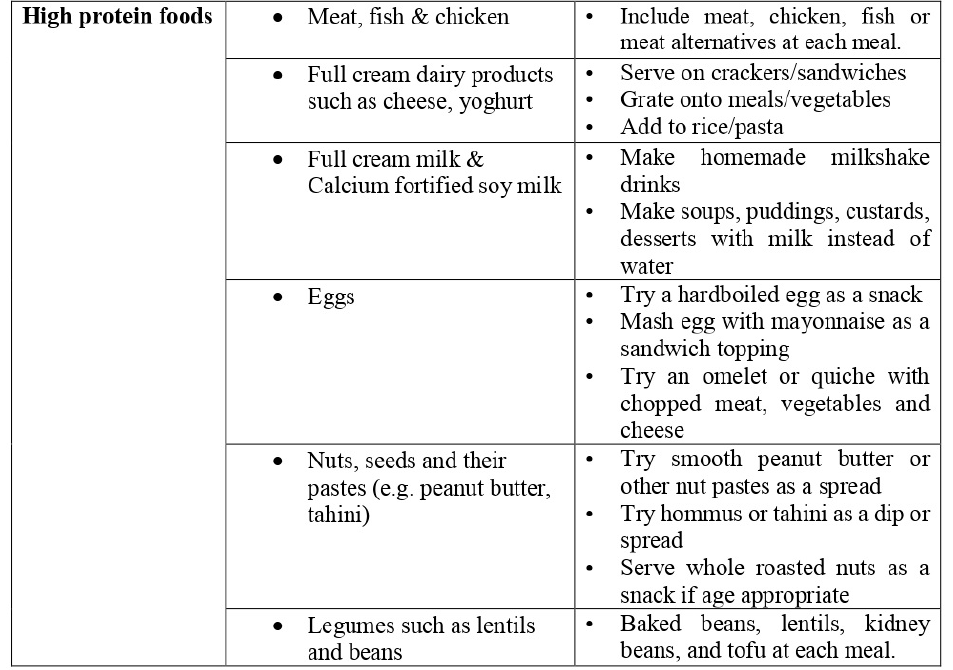
Figure 2. Recommended high-protein diet chart.